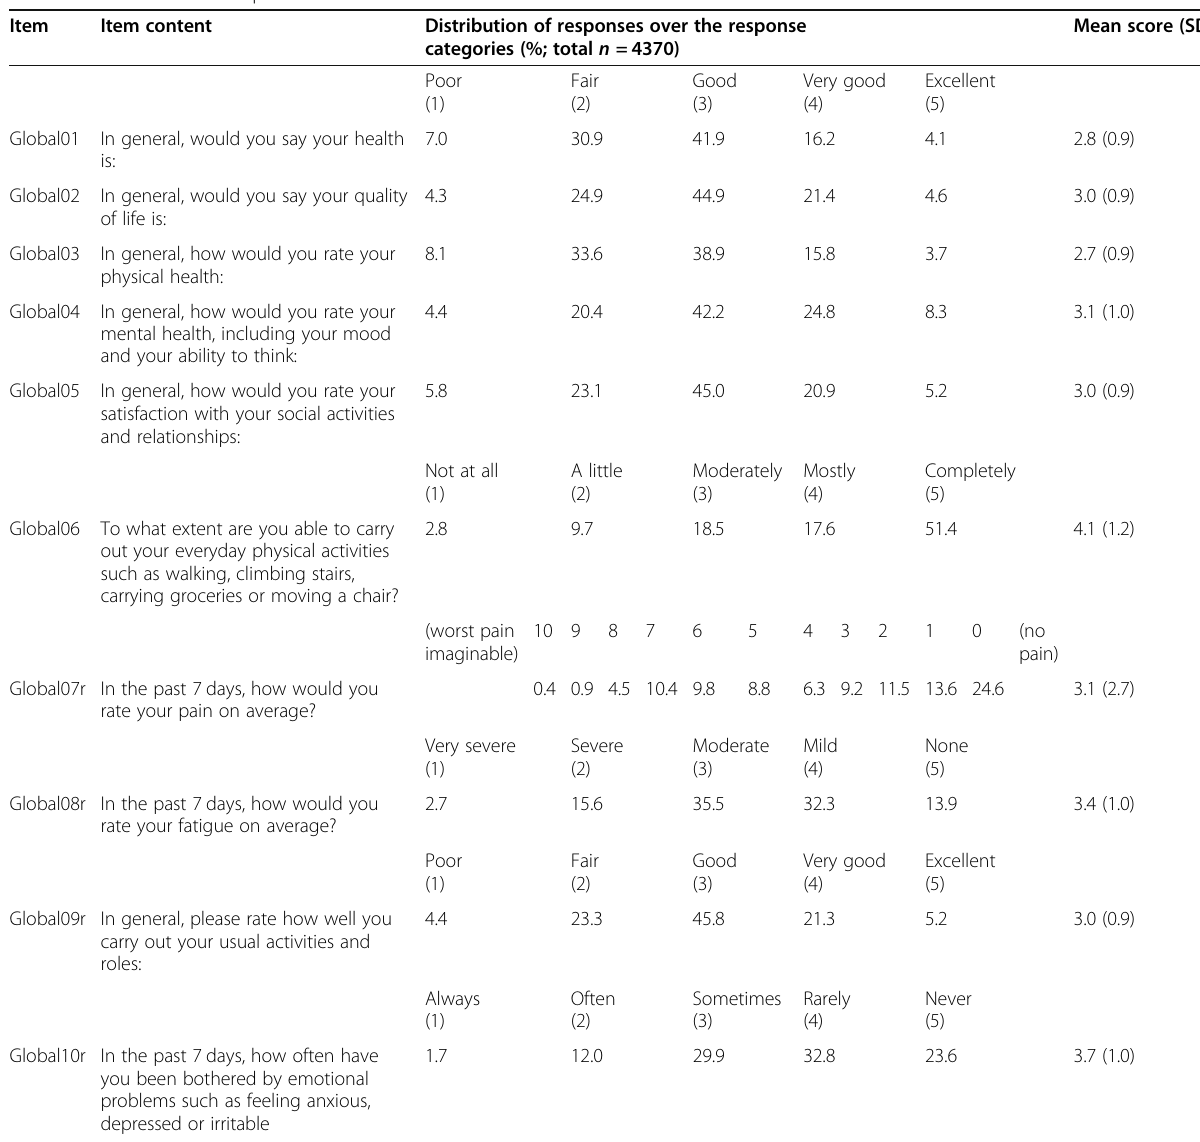
Table 2 Distribution of responses to PROMIS-GH items